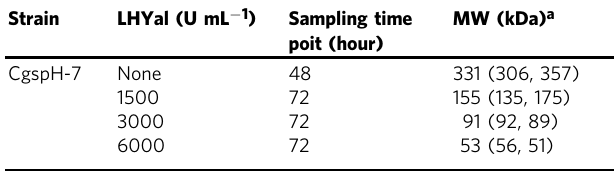
Table 2 Weight average MW of HA produced in fed-batch cultivations supplemented with different titers of